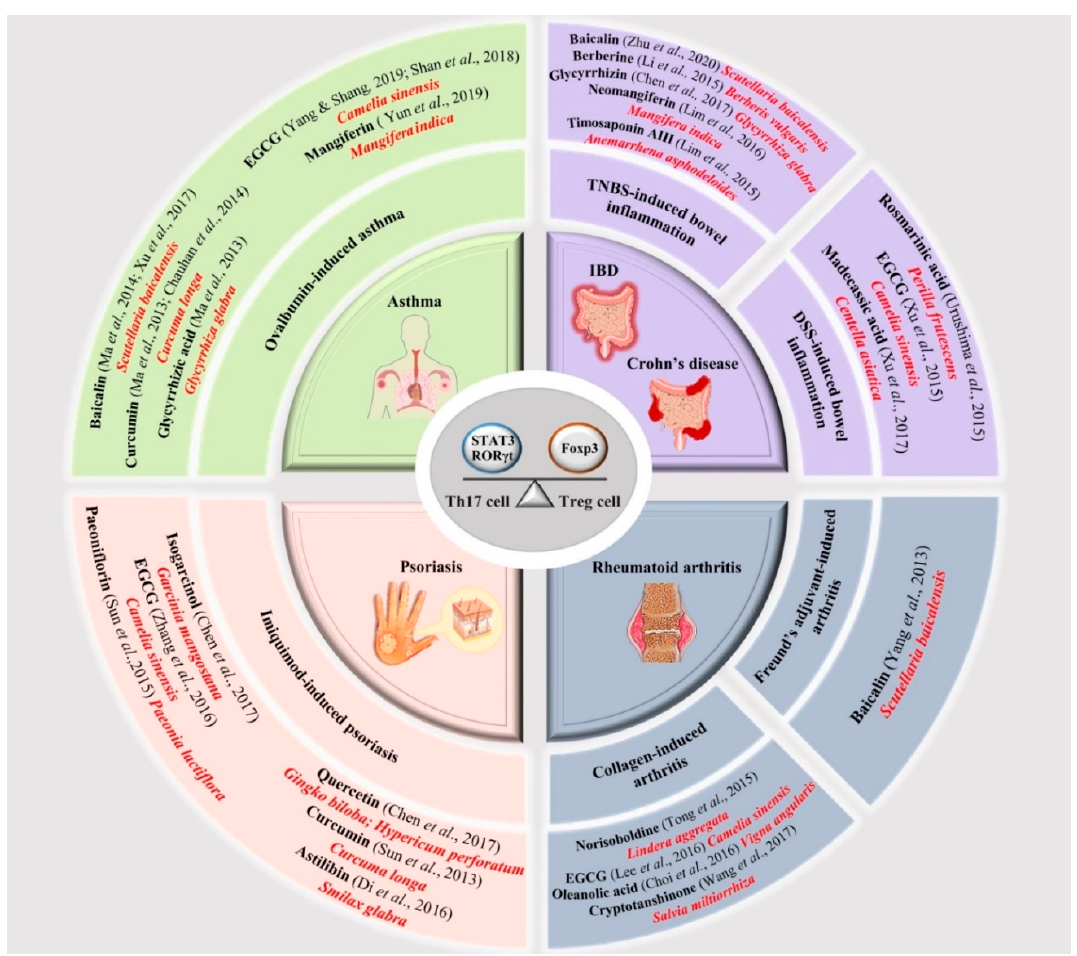
Figure 2. Schematic representation of natural compounds (black bold), by different botanical sources (in red) targeting Th17/Treg ratio as alternative therapies for different autoimmune-based diseases. The figure, also, shows the pre-clinical models (black bold), where these active components have been tested with related bibliographic references.